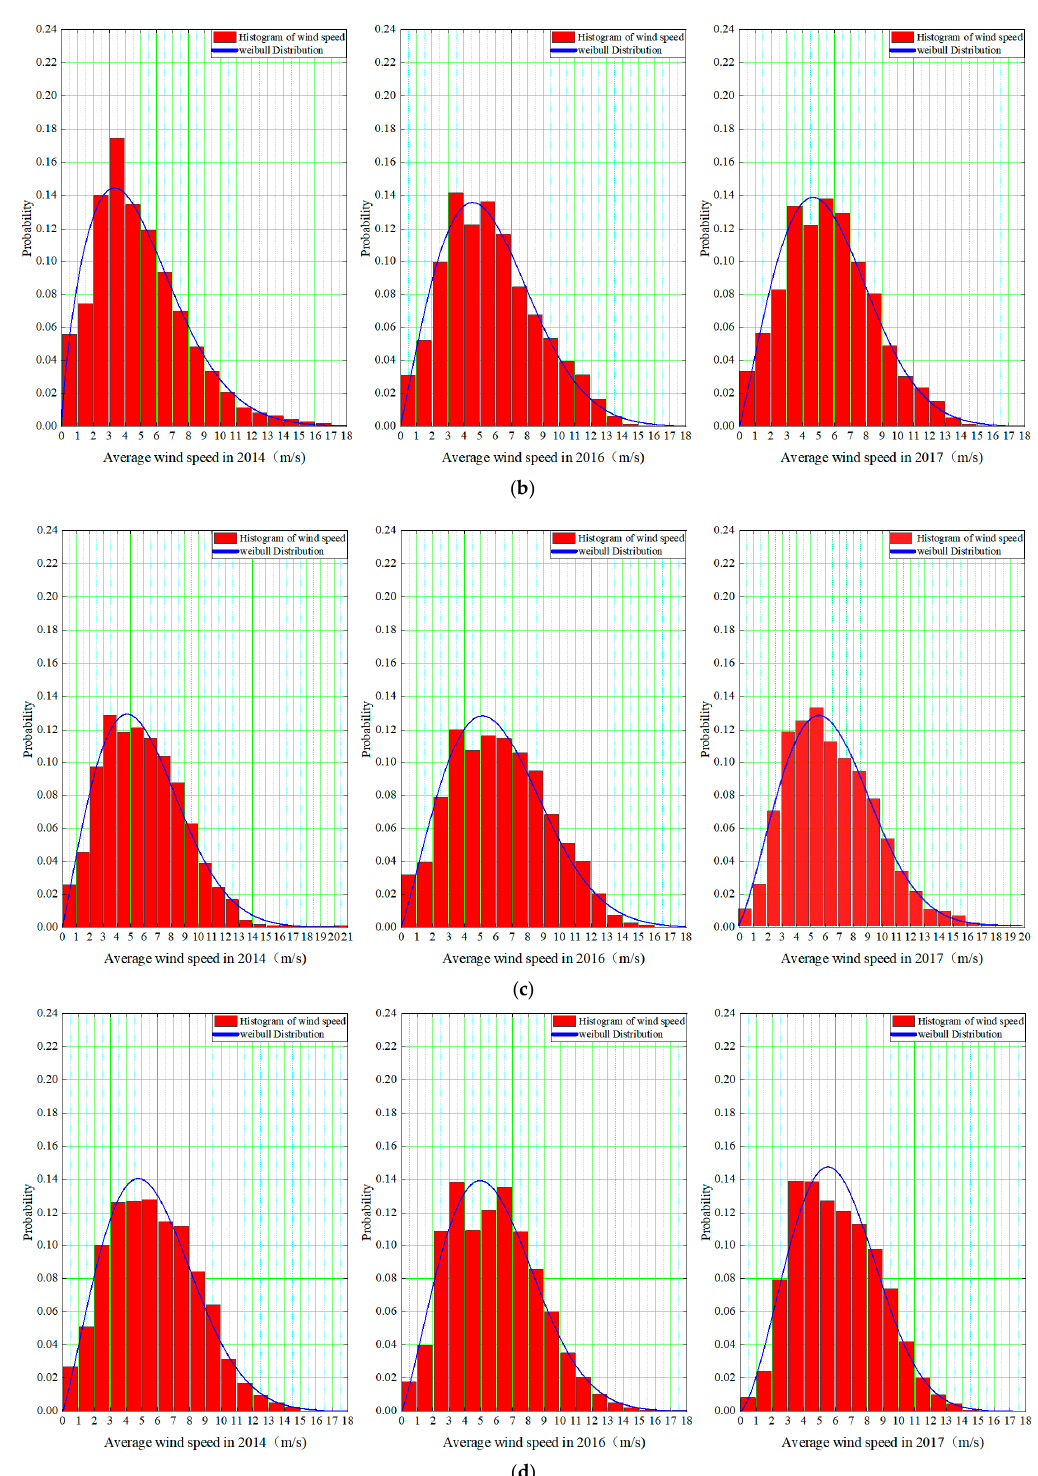
Figure 8. Histogram of seasonal wind speed distribution in 3 years: ( a ) spring (March–May); ( b ) summer (June–August); ( c ) autumn (September–November); ( d ) winter (December–February).